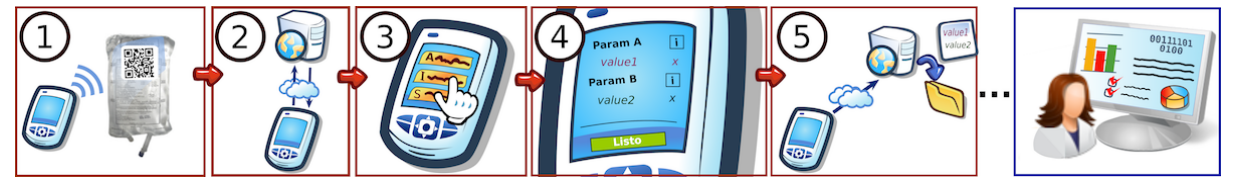
Figure 1. General behavior of the software